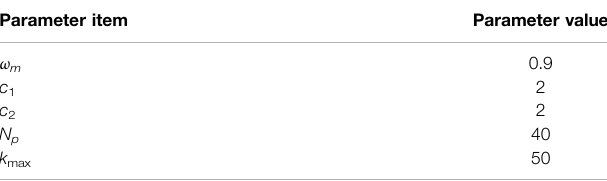
TABLE 2 | Simulation parameters of PSO in the upper level for the benchmark study. Parameter item